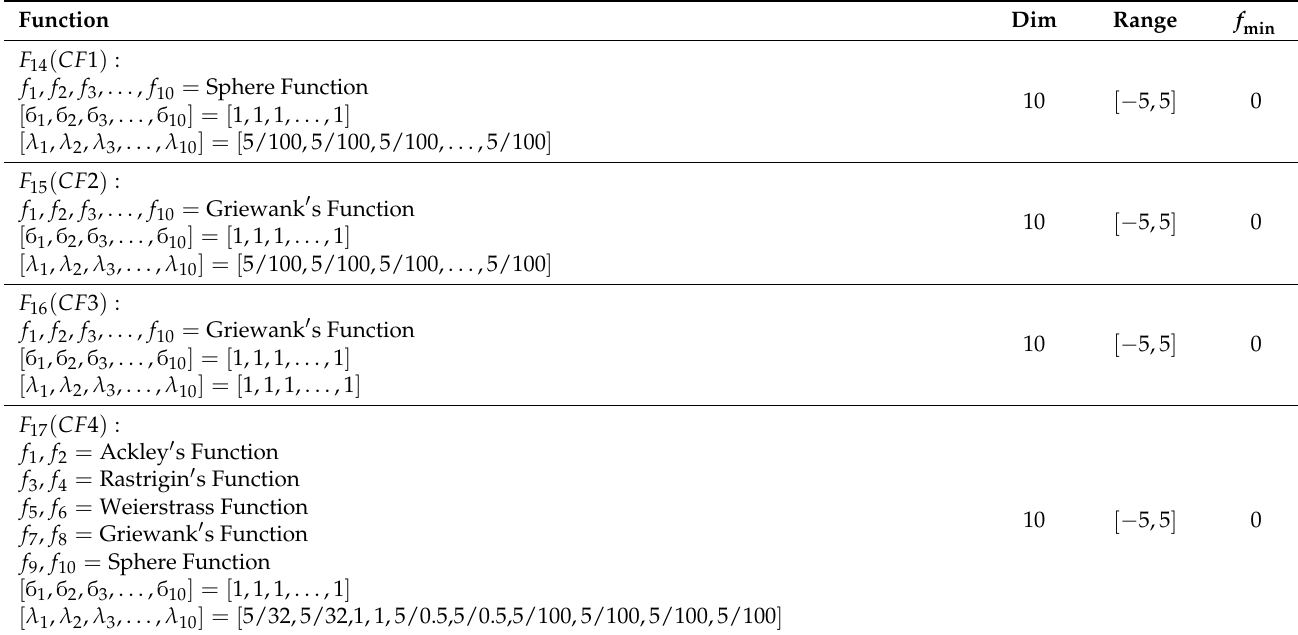
Table A3. Composite test